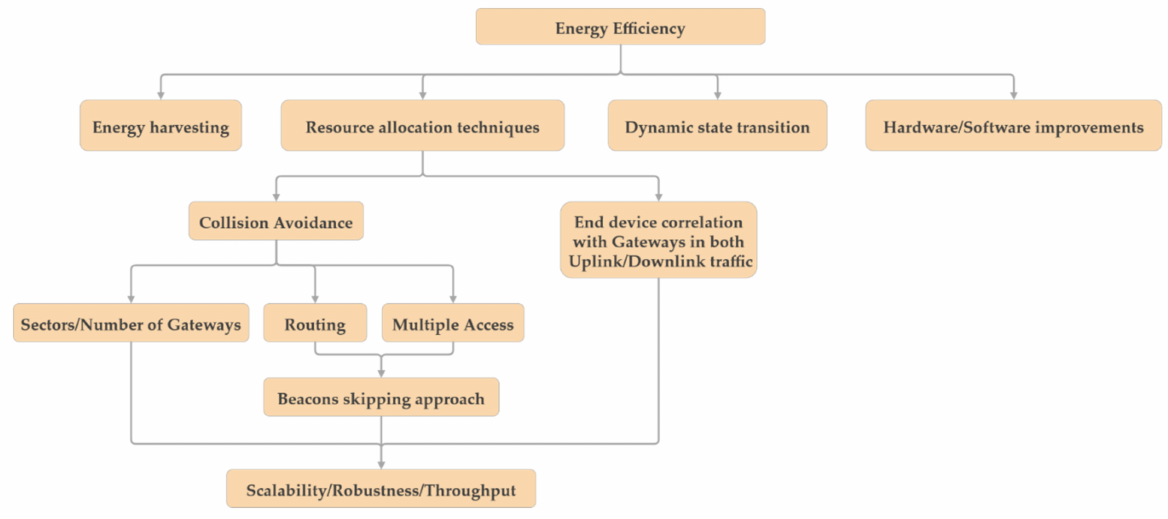
Figure 5. Critical aspects to be considered in the design of LoRaWAN communication protocol with focus on energy